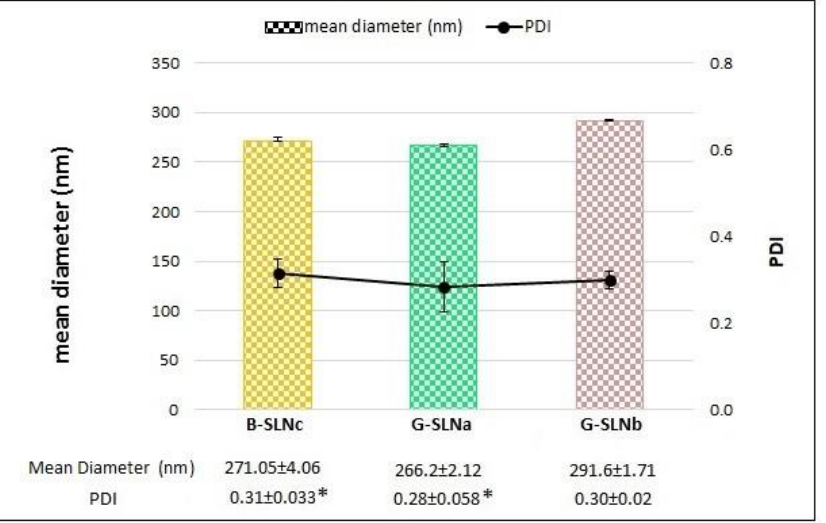
Figure 1. Particle size and PDI of loaded and unloaded SLN. PDI, p < 0.05: *= B-SLNc vs G-SLNa. Results are reported as mean ± standard deviation (SD).